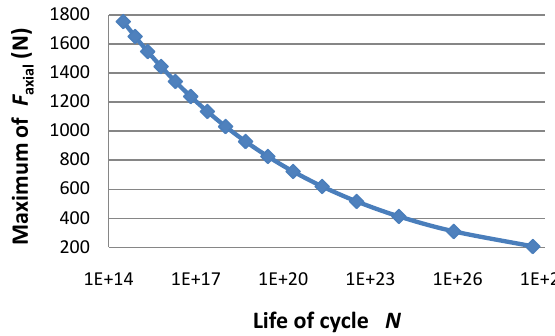
Figure 5. Relationship between the maximum axial force and the life cycle.